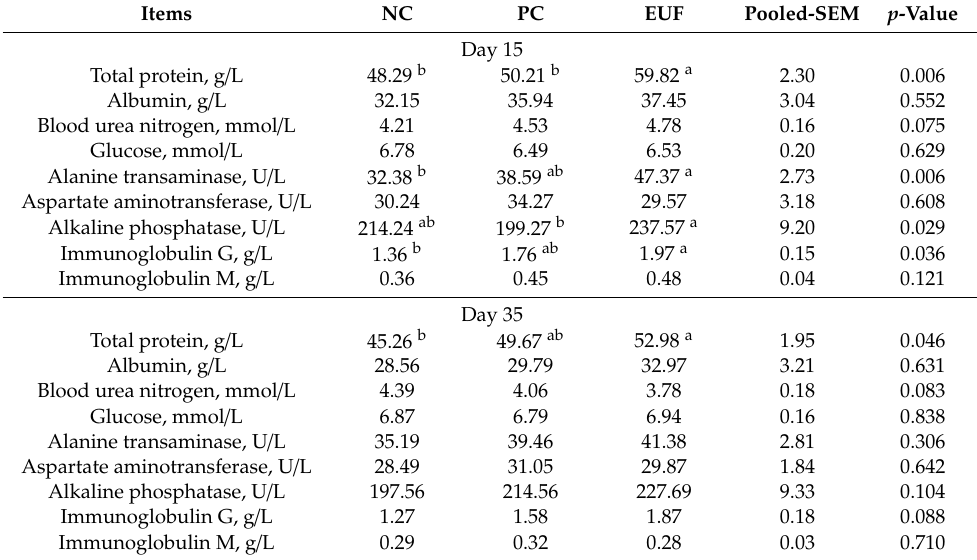
Table 2. Serum biochemical parameters of piglets 1,2